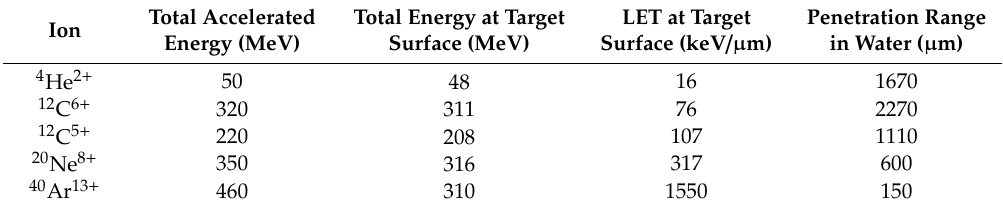
Table 1. Properties of ion beams used for mutation breeding at the National Institutes for Quantum and Radiological Science and Technology